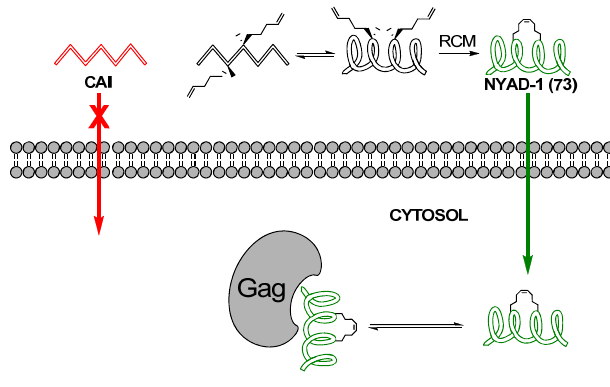
Figure 18. Stapling improves the cell permeability, affinity for the C-CA domain of Gag and anti-HIV-1 activity of the dodecapeptide